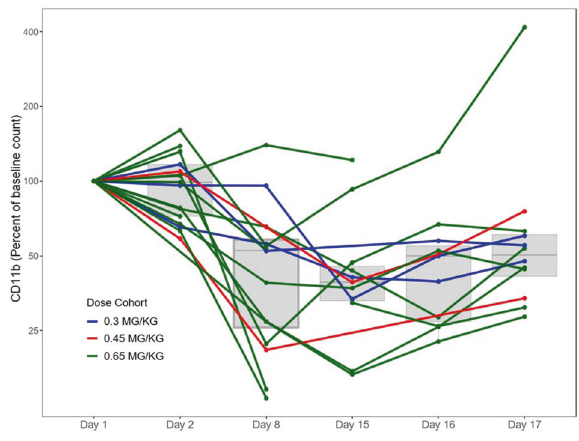
Fig. 1 Flow cytometry analysis of percent change in CD11b expressing monocytes from baseline count. In cases of delayed sampling, the actual time points are